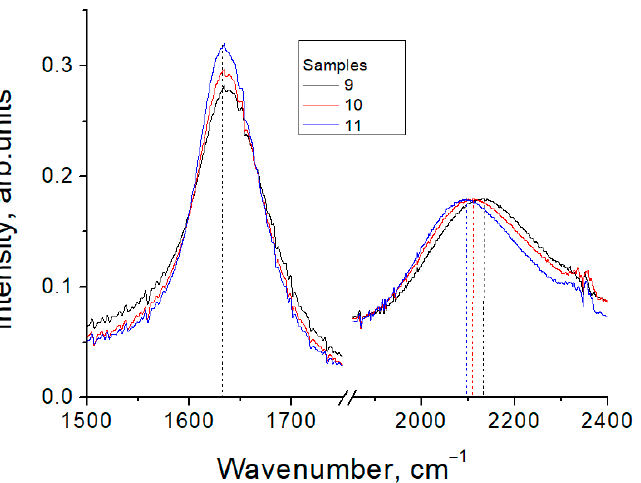
Figure 7. Deformation (1500–1800 cm − 1 ) and libration (1900–2400 cm − 1 ) bands in the IR spectra of samples 9–11. Dashed vertical lines show the position of the bands’ peaks.